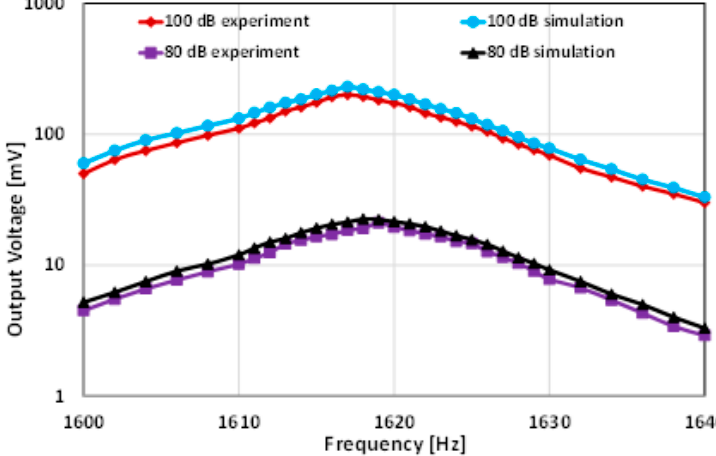
Figure 7. Simulation and test results of the device at different